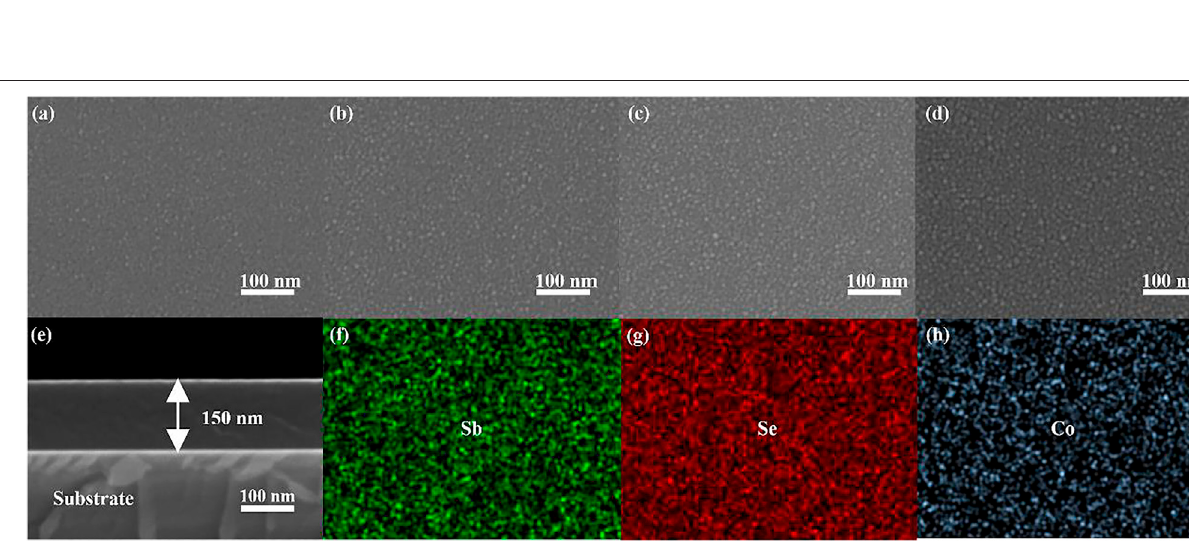
Frontiers in Materials |